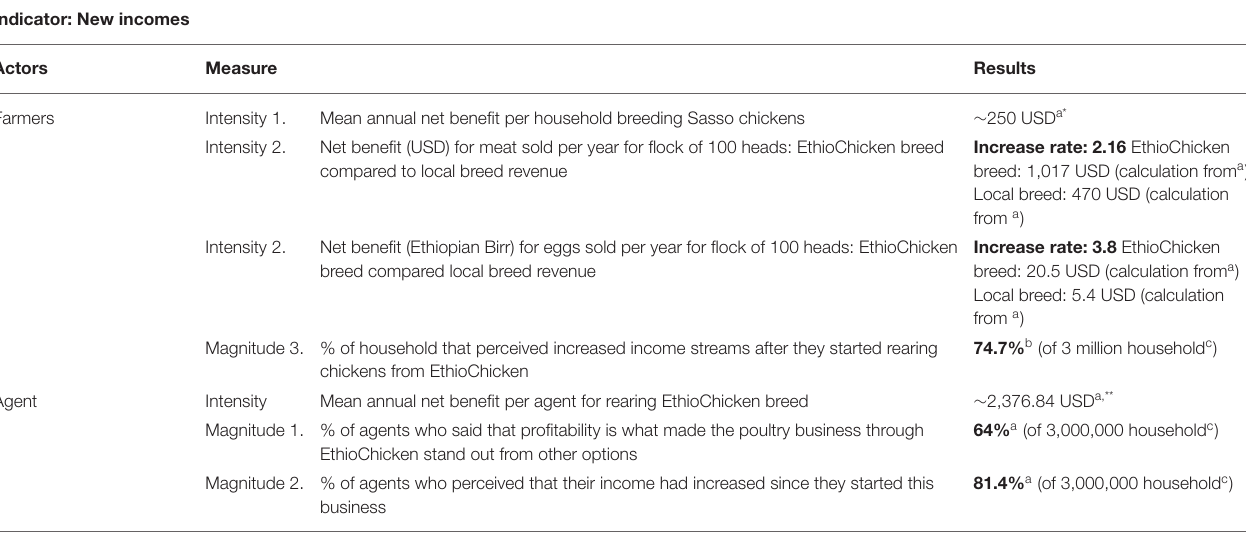
TABLE 1 | Indicators of business impacts related to different stakeholders generated by the PPPs between the Ethiopian government and EthioChicken. Indicator: New